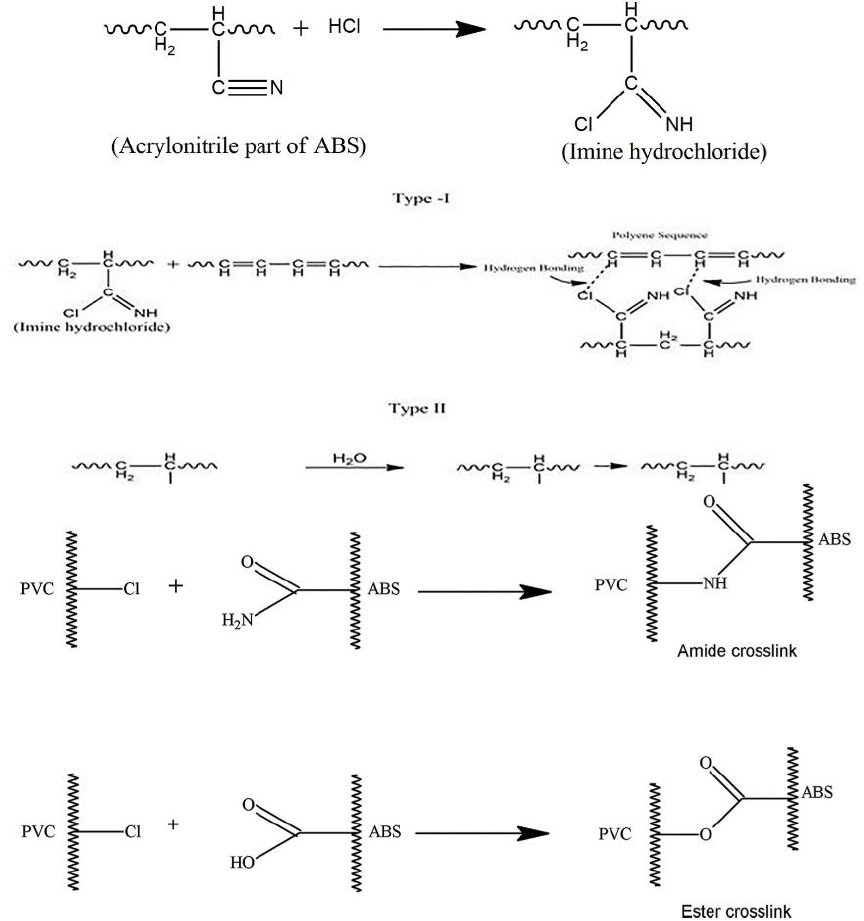
Figure 37. Schematic of the plausible cross-linking in recycled PVC/ABS blends. Reprinted with permission from ref.